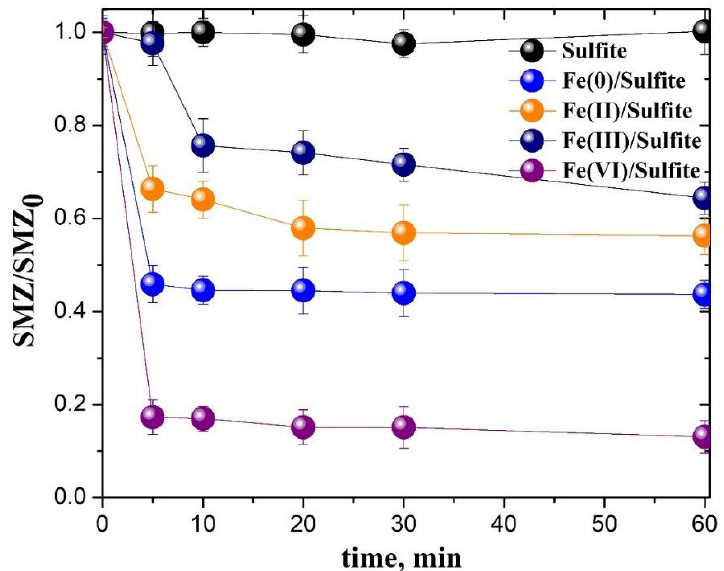
Figure 2. Degradation kinetics of SMZ as a function of the iron-based system used. Initial conditions: [SMZ] = 5.38 × 10 − 5 M, [Fe(0)] 0 = [Fe(II)] 0 = [Fe(III)] 0 = [Fe(VI)] 0 = 1.79 × 10 − 2 M, [sulfite] = 5.0 × 10 − 3 M, pH 3, T = 298 K